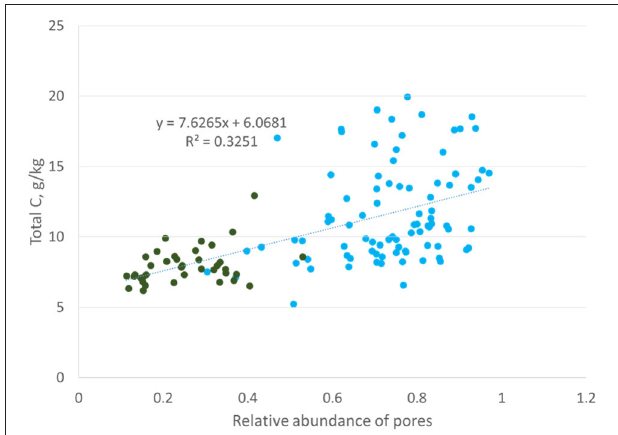
FIGURE 8 | Correlation between total carbon and abundance of 15–37.5 µ m pores (Ananyeva et al., 2013, blue reproduced with permission from Elsevier) or 15–40 µ m pores (this study, green). The y-axis is presented as total C, g/kg instead of %C to align with the original Ananyeva et al. (2013)